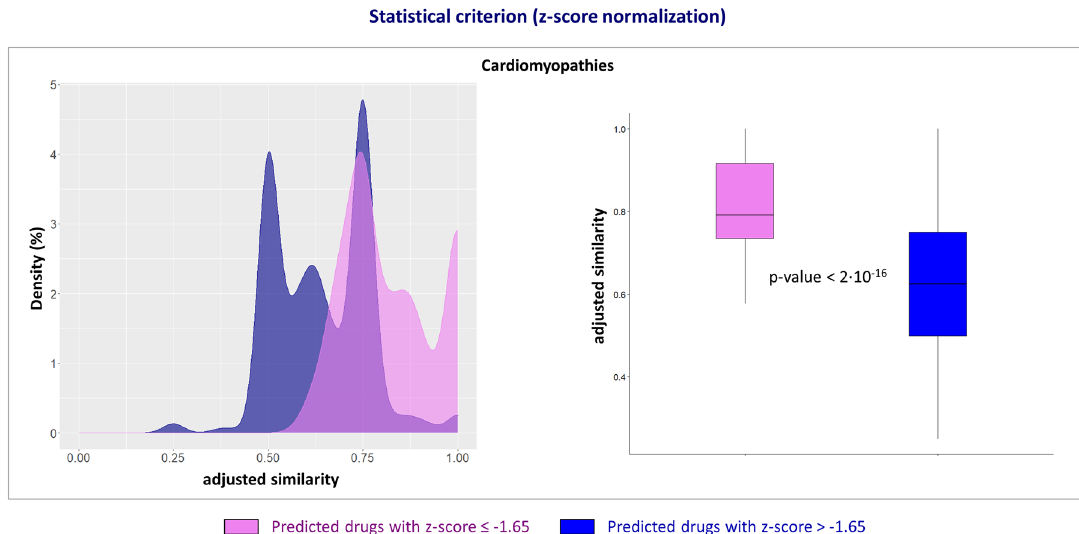
Fig. 3 Drug-disease proximity criterion. Kernel density estimate plots (left) and box plots (right) for the adjusted similarity values of the statistically signi fi cant drugs (pink plot, corresponding to a z -score ≤ − 1.65) and those not statistically signi fi cant (blue plot, corresponding to a z -score > − 1.65) predicted by SAveRUNNER as repurposable for cardiomyopathies. t -test was used to compare the two distributions, and statistical signi fi cance was found ( p -value < 0.05). Box-plot elements are so de fi ned: center line, median; box limits, upper and lower quartiles; points,